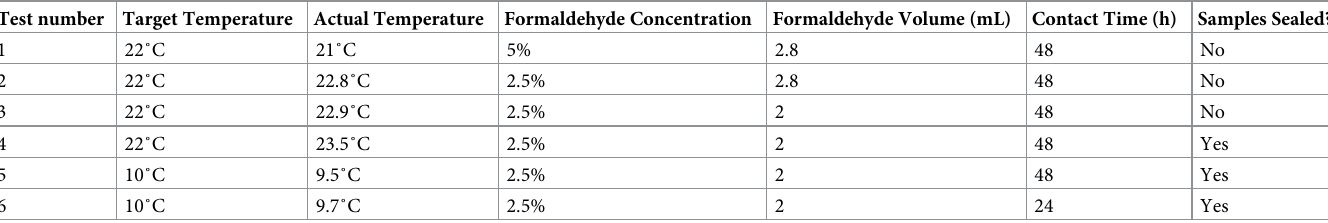
Table 1. Overview of test